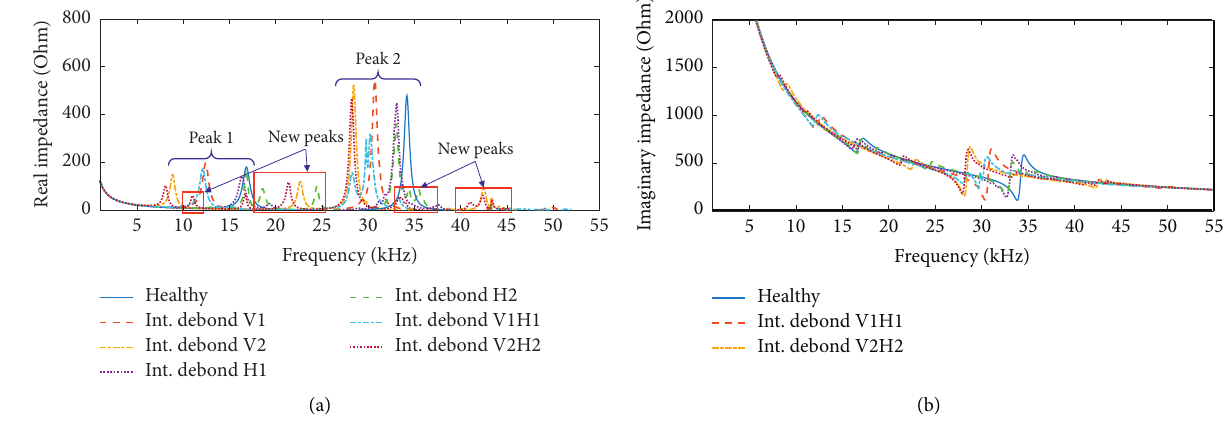
Figure 26: Numerical EMI signatures under interface debonding defects. (a) Real part. (b) Imaginary